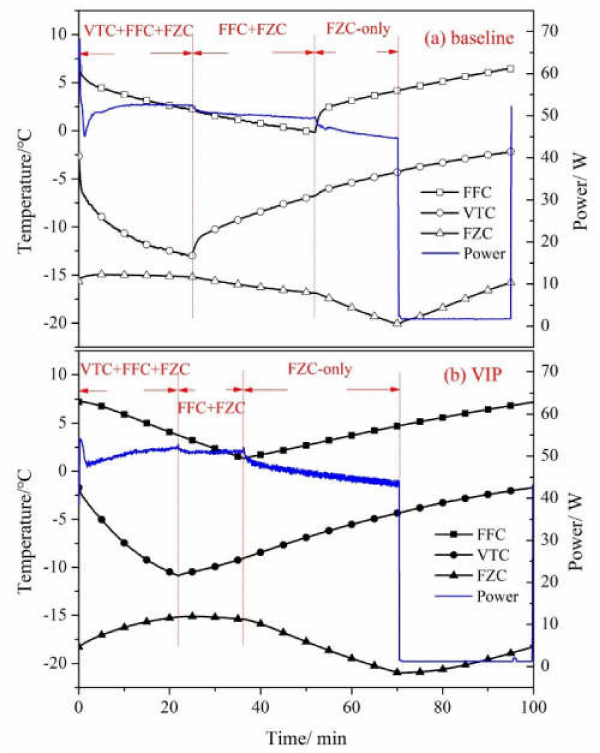
Figure 4. Variations in cabinet temperature during the 14th on / o ff cycle: ( a ) baseline case; ( b ) VIP case. Table 4. Time-averaged cabinet temperature during the 14th on / o ff cycle in both cases.